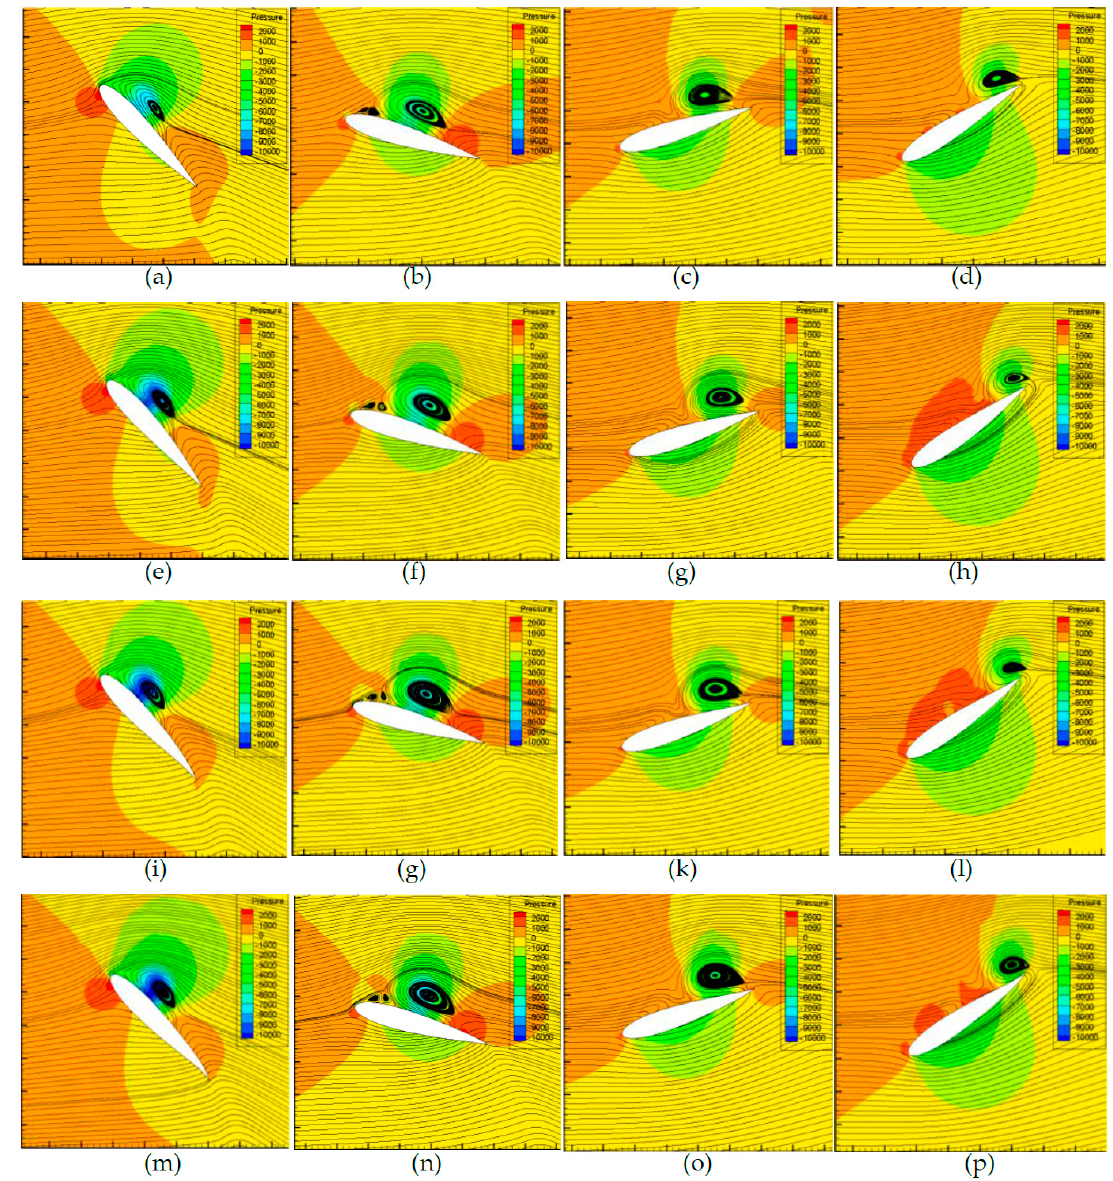
Figure 9. Contours of vortices with streamlines and pressure (Pa) of flexible hydrofoil in the case δ c = 0.05 c and f * = 0.13 (the thicker the blue, the stronger the vortex). ( a ) rigid, θ = − 45 ° , ( b ) rigid, θ = − 16 ° , ( c ) rigid, θ = 16 ° , ( d ) rigid, θ = 31 ° , ( e ) n = 2, θ = − 45 ° , ( f ) n = 2, θ = − 16 ° , ( g ) n = 2, θ = 16 ° , ( h ) n = 2, θ = 31 ° , ( i ) n = 5, θ = − 45 ° , ( j ) n = 5, θ = − 16 ° , ( k ) n = 5, θ = 16 ° , ( l ) n = 5, θ = 31 ° , ( m ) n = 10, θ = − 45 ° , ( n ) n = 10, θ = − 16 ° , ( o ) n = 10, θ = 16 ° , ( p ) n = 10, θ = 31 ° .